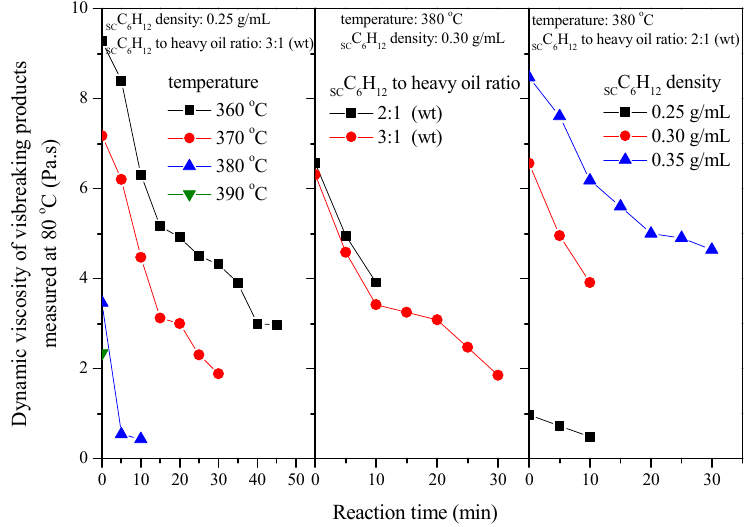
Figure 2. Viscosity reduction in heavy oil under various SC C 6 H 12 environments.